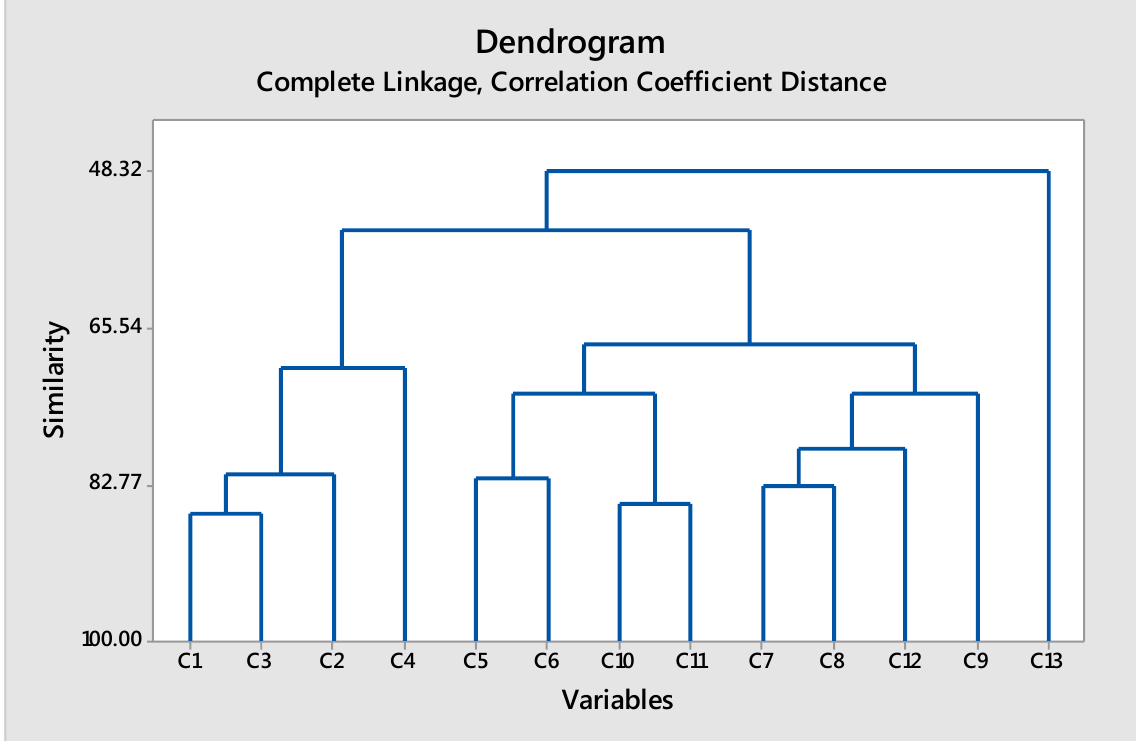
Figure 6. Dendrogram showing similarity level of the microbiological count between the examined distribution points of the water network in a healthcare